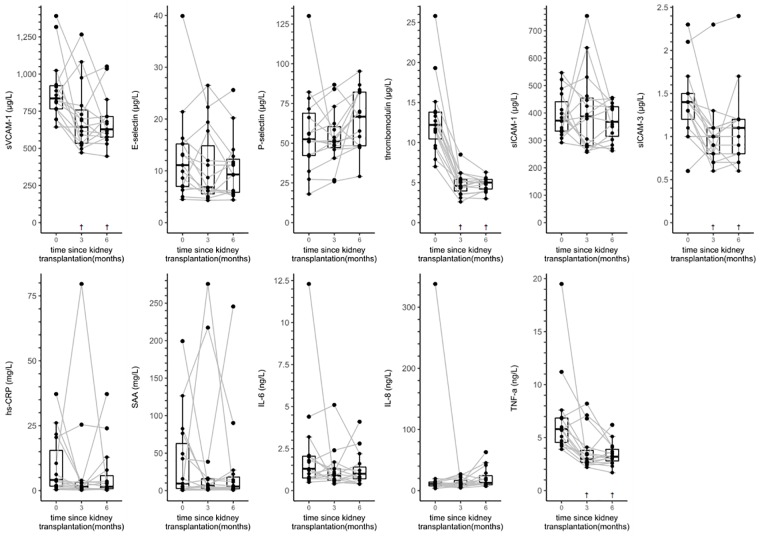
Boxplots and individual trajectories of serum biomarkers of endothelial dysfunction and low-grade inflammation over time in kidney transplant recipients.Abbreviations: hs-CRP, high-sensitivity C-reactive protein; IL-6, interleukin 6; IL-8, interleukin 8; NA, not applicable; SAA, serum amyloid A; sICAM-1, soluble intercellular adhesion molecule 1; sICAM-3, soluble intercellular adhesion molecule 3; sVCAM-1, soluble vascular cell adhesion molecule 1; TNF-α, tumor necrosis factor alpha. †
P value < 0.05 vs. baseline based on linear mixed model analyses with a random intercept.